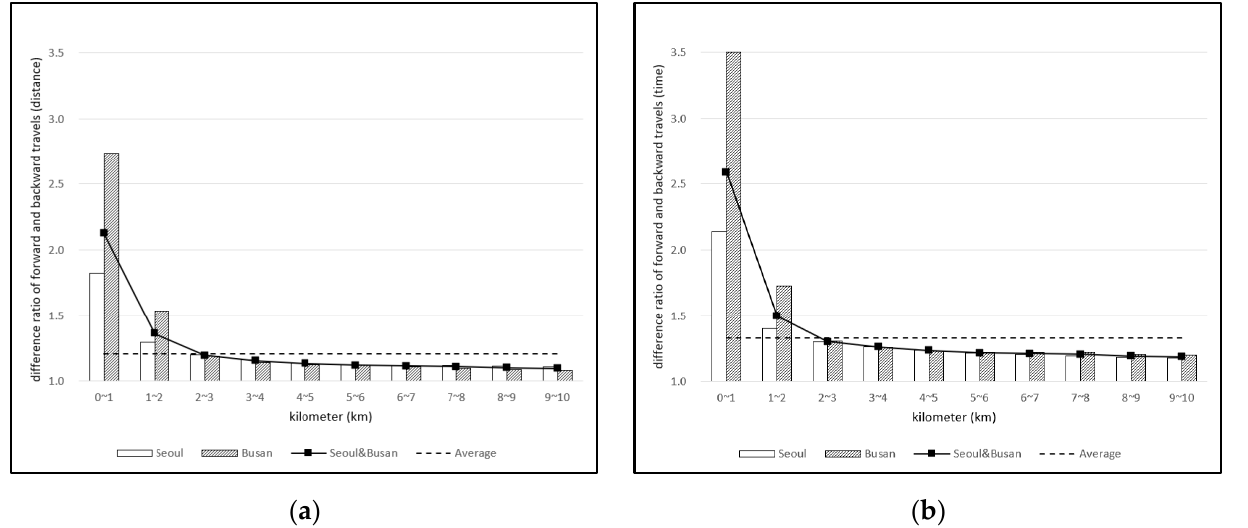
Figure 10. Cost difference between outbound and return trips: ( a ) Road distance; ( b ) road time.